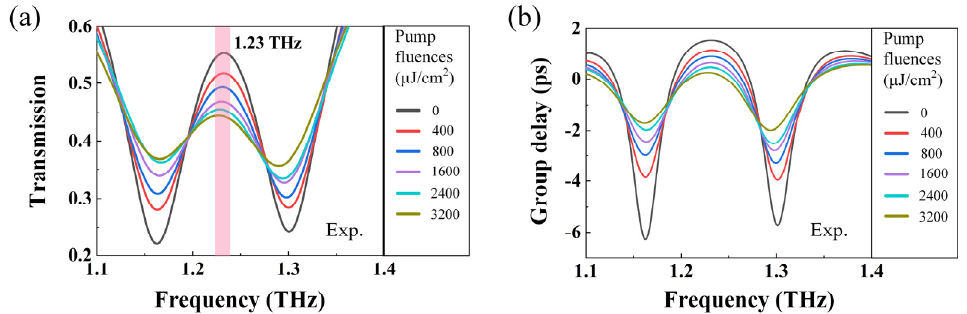
Figure 4. Pump fluence-dependent EIT response of the MoTe 2 -coated metasurface. ( a ) Measured THz transmission spectra for different pump fluence from 0 to 3200 µ J/cm 2 . ( b ) Measured group delays for different pump fluence from 0 to 3200 µ J/cm 2 .